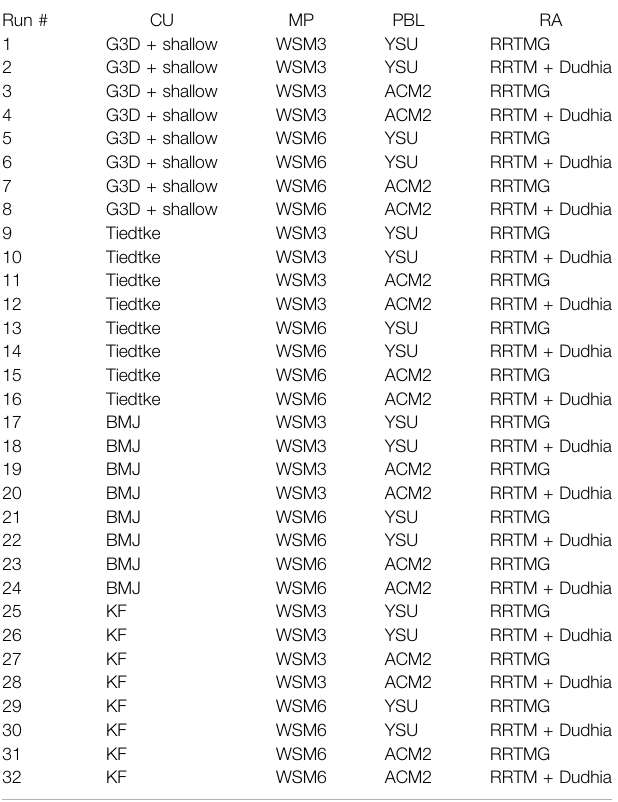
TABLE 1| Tested 32WRFsetupsofparameterization combinationsof4cumulus convection(CU),2microphysics(MP),2planetaryboundarylayer(PBL),and2 radiation (RA) physics